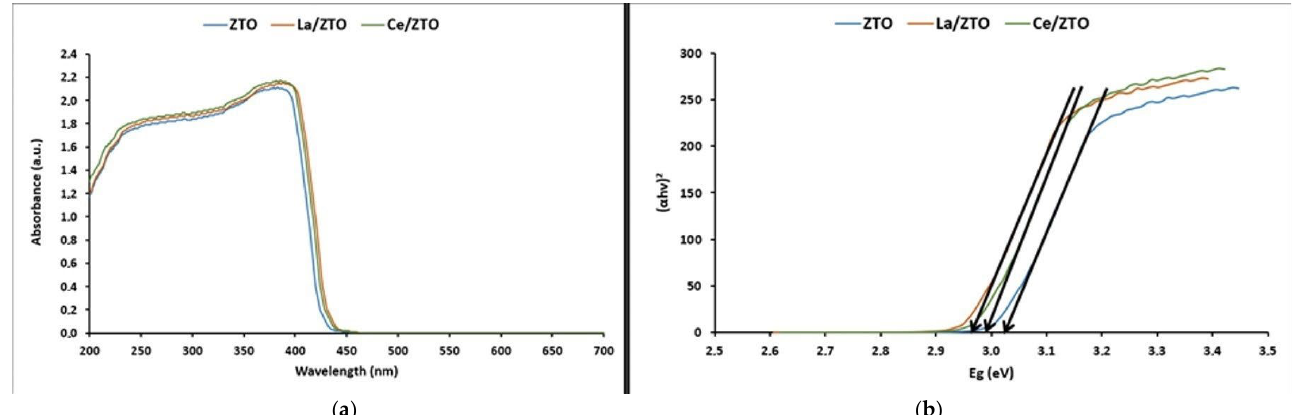
Figure 3. ( a ) UV-vis DRX and ( b ) plots of (αhv) 2 vs. E g of ZTO, La/ZTO, and